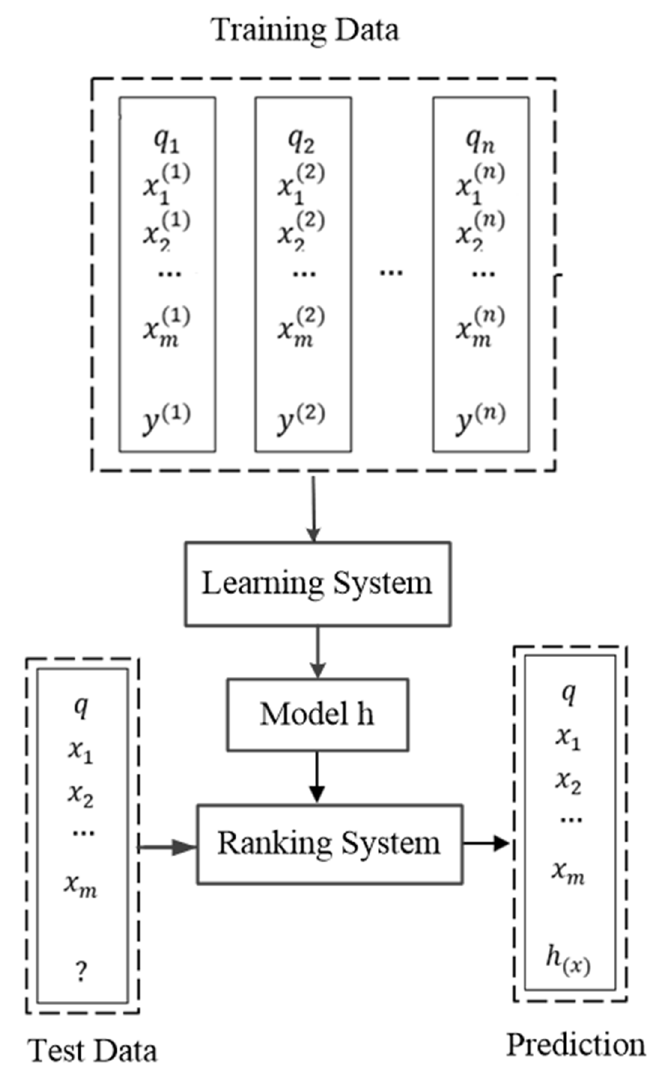
Figure 3. Learning-to-rank